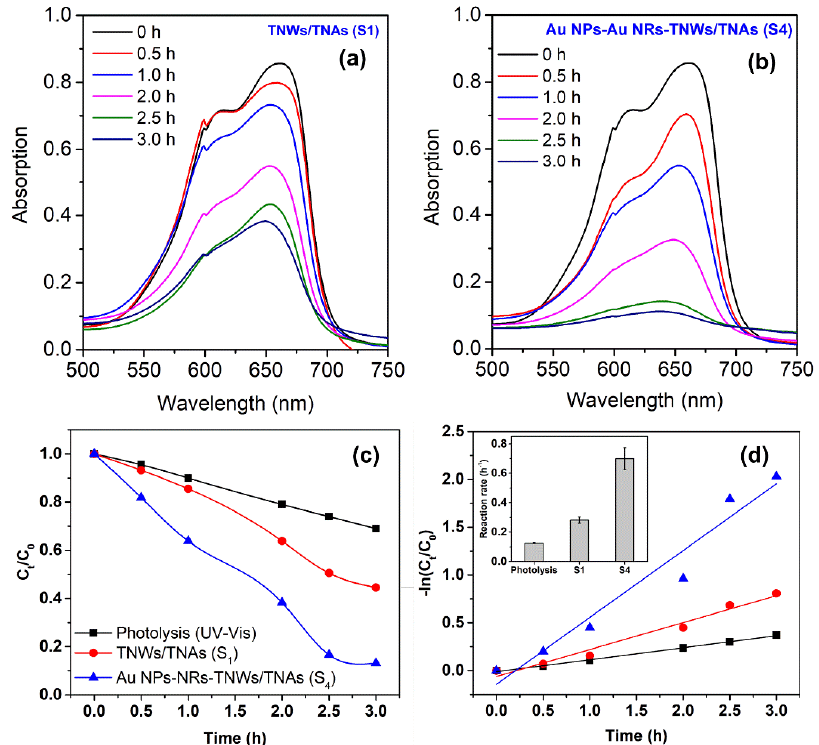
Figure 8. ( a , b ) Changes in UV-visible absorption spectra of MB by TNWs/TNAs (S 1 ) and Au NPs- NRs- TNWs/TNAs (S 4 ) as a function of irradiation time. ( c , d ) Variations in (C t /C 0 ) and − ln(C t /C 0 ) as a function of irradiation time. Inset in ( d ) is the reaction rate constant ( k ) of S 1 and S 4 . For reference, Table 2 summarizes the k values of TiO 2 -based nanophotocatalysts pre- pared by some methods in this study and the relevant literature [10,50 – 53]. It is very hard to make the right comparison when each developed TiO 2 -based nanophotocatalyst has its intrinsic properties (e.g., morphology-surface area, crystal structure, composition, deco- ration, or doping content) and different photocatalytic reaction conditions (e.g., catalyst dosage, light source, initial concentration of MB). Generally, the k value of the present TNWs/TNAs (0.28 h −1 ) was twice higher than those of the 40 nm-TNAs/ 20 nm-TNWs (0.13 h −1 ) and the TiO 2 nanoparticles film (0.14 h −1 ) in ref. [10], which could be due to the larger surface area associated with the thicker TNAs and longer TNWs film in this study. Mean- while, the k value of Au NPs-NRs- TNWs/TNAs (0.7 h −1 ) was comparable with those of the optimal Ag/TiO 2 nanoparticles (0.65 h −1 ) [50] and the Bi-Fe doped TiO 2 (0.78 h −1 ) [51]. However, the k value of Au NPs-NRs- TNWs/TNAs was 2.1 – 2.7 times lower than the k values of the brookite phase TNAs (1.45 h −1 ) synthesized by anodization and annealed at 500 ° C [53], and of the SnO 2 NPs-decorated TNAs (1.86 h −1 ) prepared by anodization and solvothermal process [52].